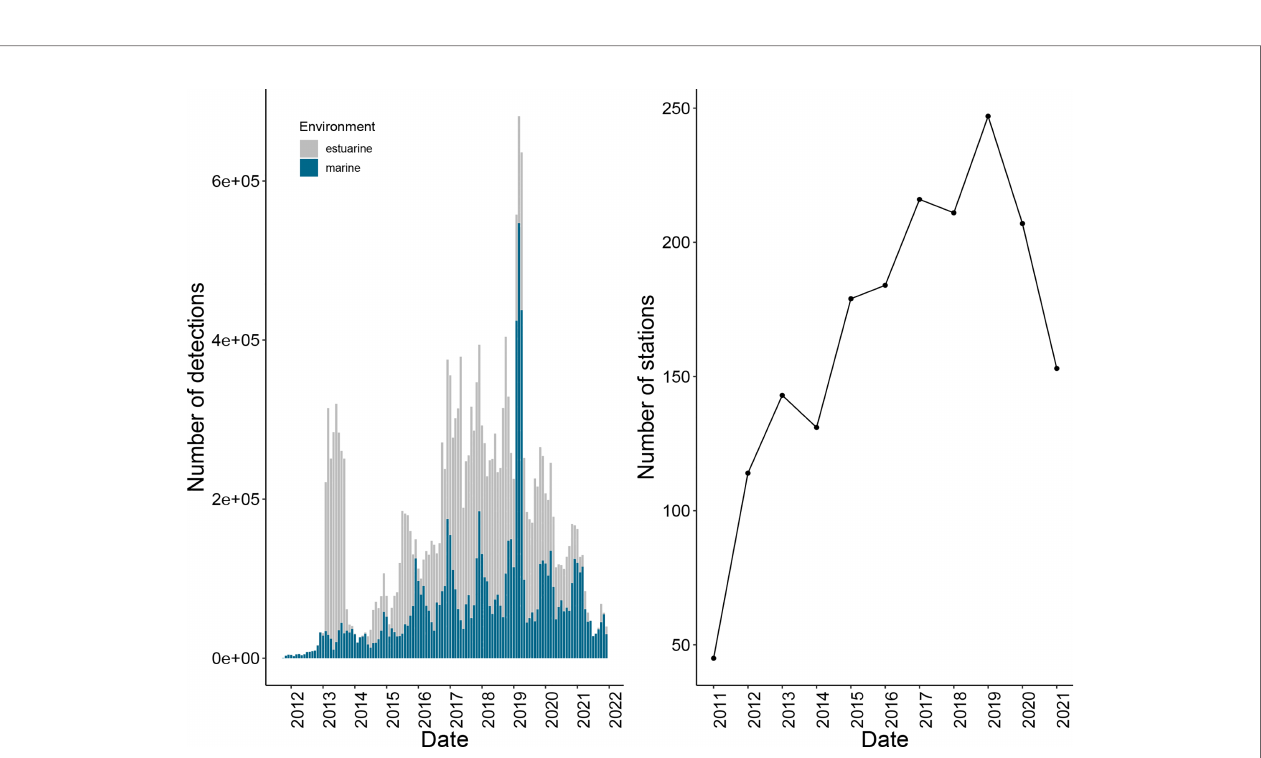
FIGURE 5 | Number of detections recorded monthly on ATAP receivers between October 2011 and December 2021 (left). Blue bars denote detections recorded on receivers deployed in the nearshore environment (marine), and grey bars denote detections recorded on estuarine receivers. The number of receivers deployed and active in the ATAP by year from 2011 - 2021